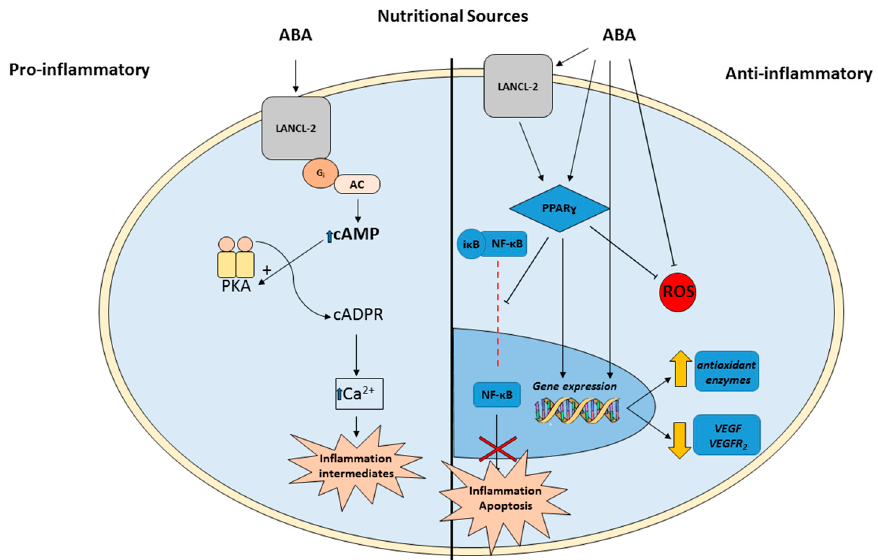
Figure 2. Schematic representation of the pro- and anti-inflammatory pathways mediated by ABA in animals with special focus on a potential anti-inflammatory, antioxidant and anti-angiogenic retinal mechanism of action. cAMP: Cyclic adenosine monophosphate; AC: Adenylyl Cyclase; PKA: Protein Kinase A; PPAR γ : Peroxisome Proliferator-Activated Receptor Gamma; NF- κ B: Nuclear Factor- Kappa B; VEGF: anti-vascular endothelial growth factor; LANCL-2: lanthioninesynthetase C-like protein 2; ROS: Reactive Oxygen Species.